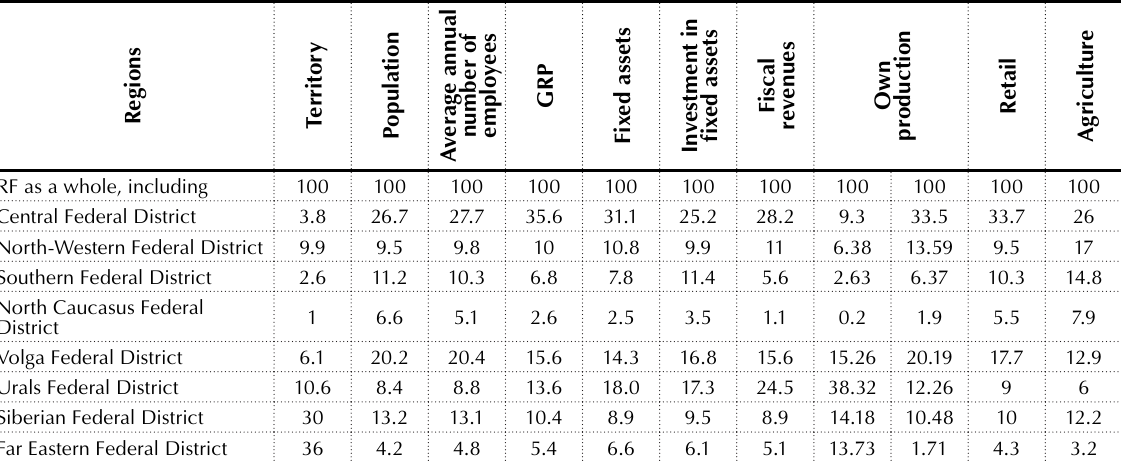
Table 1. The structure of the main indicators of regional development in the Russian Federation (as of January 1, 2016, %)